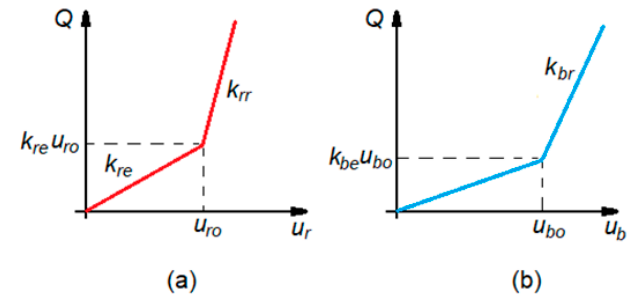
Figure 6. Bilinear function: ( a ) for rail pad; ( b ) for ballast.